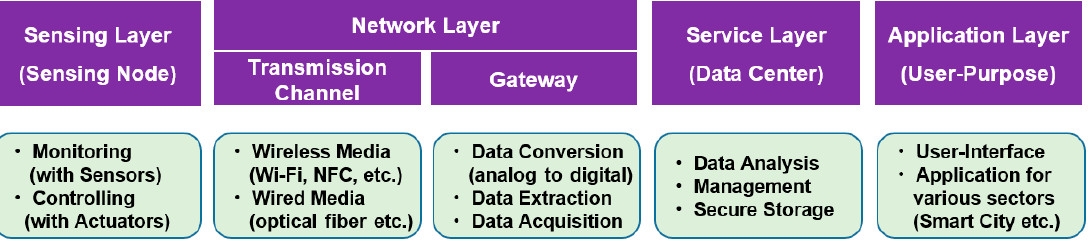
Figure 1. The general architecture of an IoT-based sensor network according to its functionality.